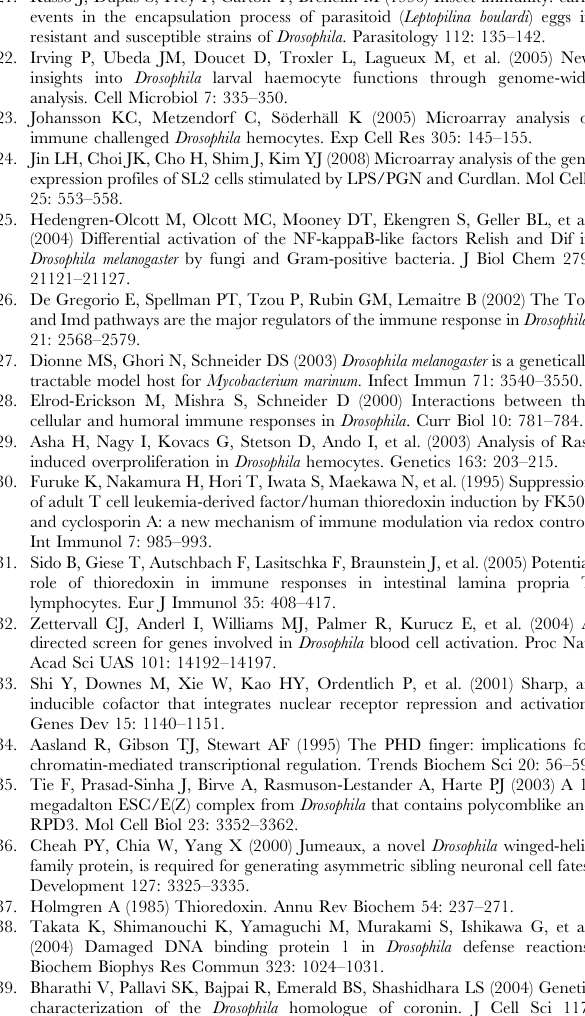
Figure S1 Germinating hyphes of B. bassiana on dead Drosophila . Found at: doi:10.1371/journal.ppat.1000168.s004 (0.45 MB TIF) Figure S2 Overexpression of the disrupted genes using the Gal4- dependent promoter of the P -element that was inserted at the 5 9 UTR of the gene in a forward orientation. Figure S3 Melanization induced by a clean injury in the 16 mutant